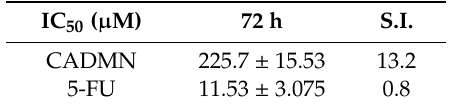
Figure 1. Cytotoxic effect of ( a ) Cardamonin (CADMN) and ( b ) 5-Fluorouracil (5-FU) against HepG2 cells. Different concentrations of CADMN and 5-FU were added to the HepG2 cells as a treatment for different time periods (24, 48 and 72 h). 5-FU was used as a positive control and 0.02% DMSO was used as a negative control (0). ( c ) The IC 50 of CADMN and ( d ) The IC 50 of 5-FU after 24, 48 and 27 h. All experiments were performed in triplicates and presented as mean ± SD. * p < 0.05, ** p < 0.01, *** p < 0.001 indicate significant difference. Table 1. IC 50 ( μ M) for cardamonin (CADMN) and 5-fluorouracil (5-FU) against Hs27 normal fibroblast cells using MTT assay at 72 h.